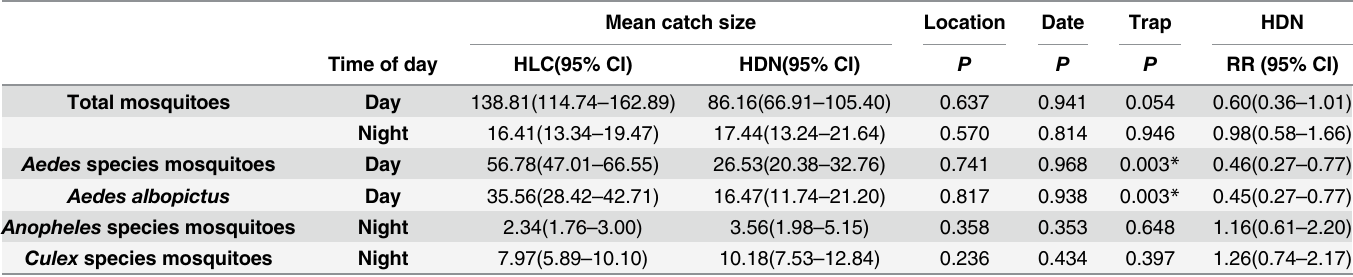
Table 3. Analysis of female mosquitoes collected by the human landing catch and human-baited double net trap comparison (experiment 2).